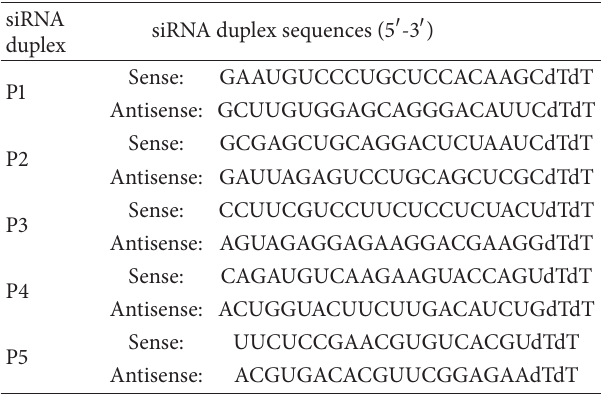
Table 1: siRNA sequences for snail targeting and negative